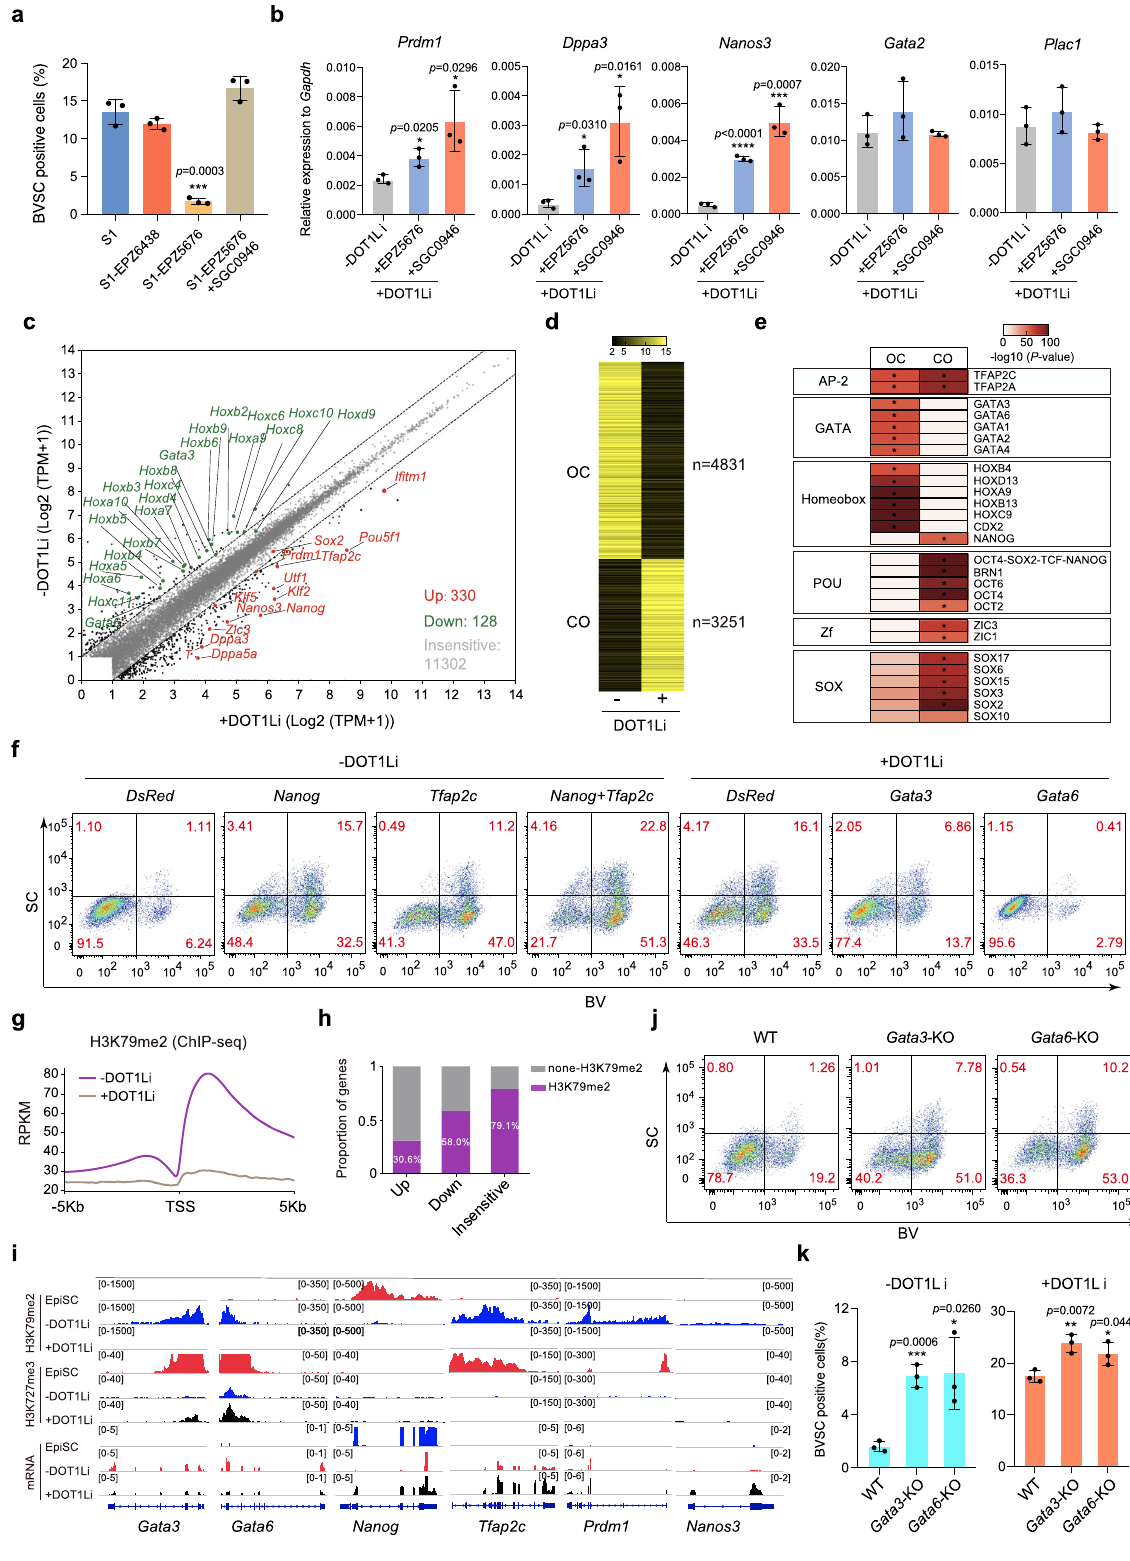
Gata2 -KO cells during BiPNT (Fig. 7e). We further sorted c-Kit for WT and two Gata2 -KO cell lines and show that Gata2 -KO leads to a signi fi cant increase of c-Kit + population at Day3 BiPNT (WT ~ 53%, KO1# ~ 76.2%, KO2# ~ 75.4%) (Supplementary Fig. 7e). RT-qPCR analysis further con fi rmed the loss of tro- phoblast markers in Gata2- KO c-Kit − cells